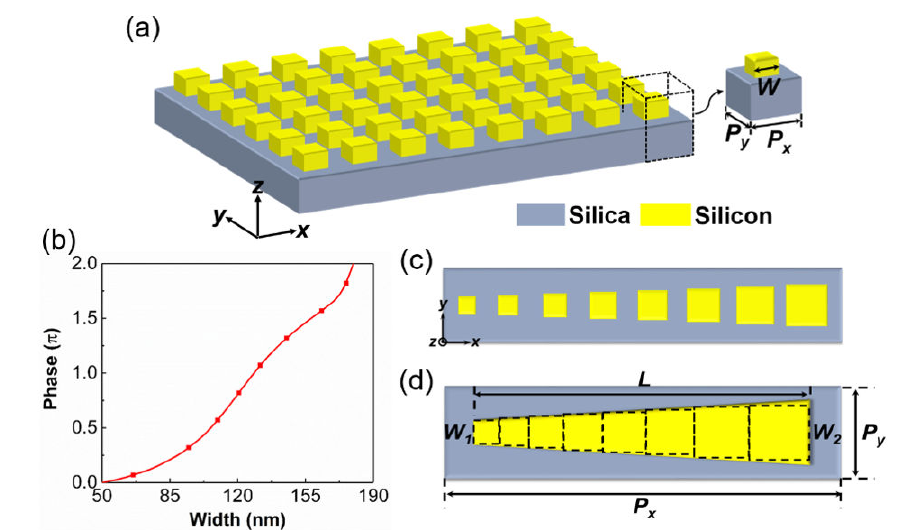
Figure A1. ( a ) Schematic of the homogeneous metasurface composed of silicon blocks rested on silica substrate. ( b ) The phase of the transmitted light as the function of the width W of the silicon block at a wavelength of 694.3 nm. ( c ) Vertical view of a supercell composed of eight different blocks. ( d ) Vertical view of a supercell of the quasi-continuous phase-gradient